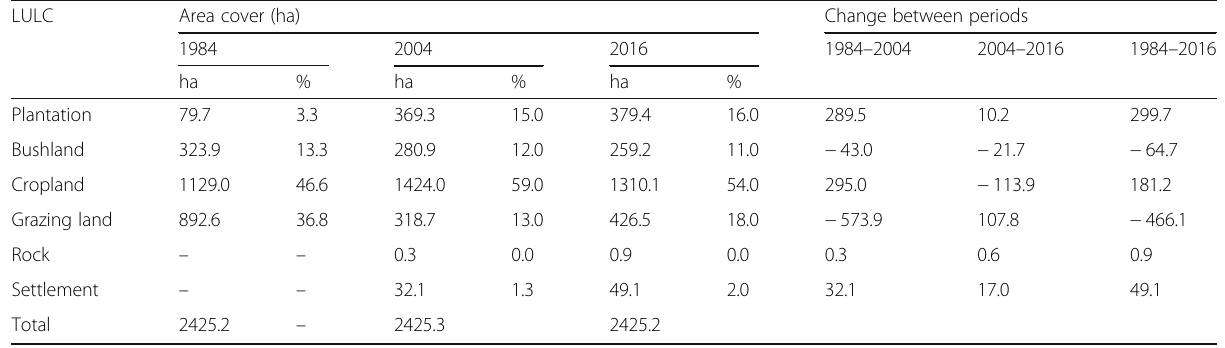
Table 4 LULC changes between 1984 and 2016 in Gudo Beret watershed LULC Area cover (ha)